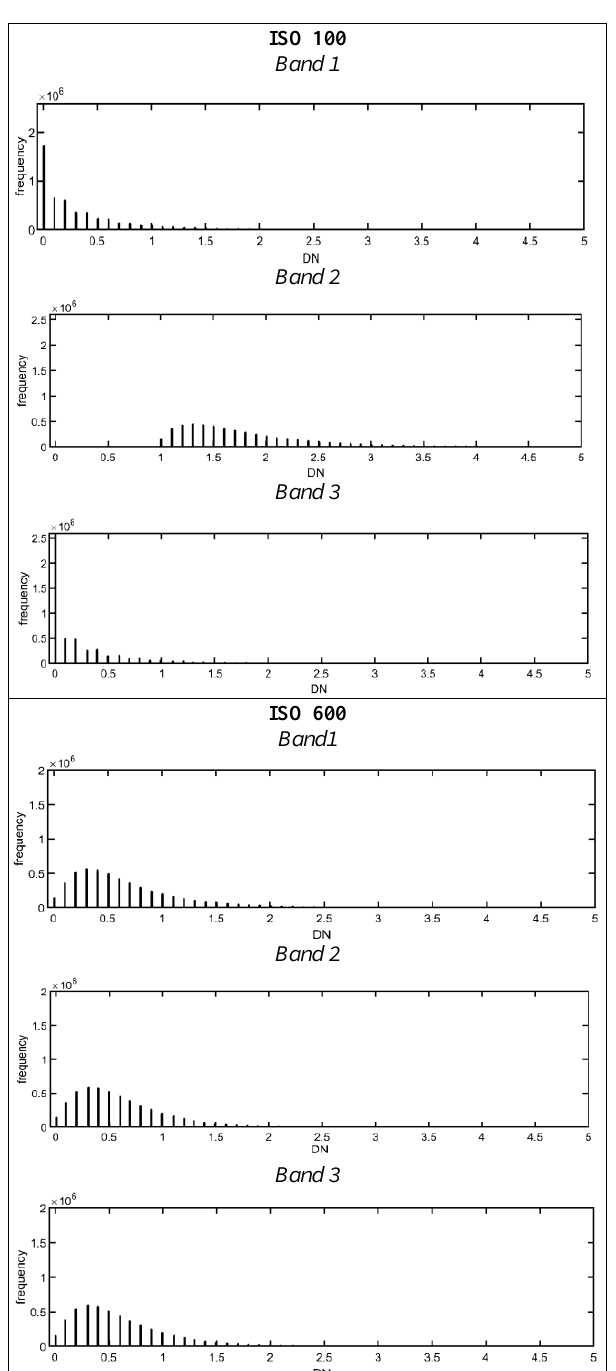
Figure 3. Histograms of distribution of dark frame assessment at 100 ISO (up) and 600 ISO (down) per band Figure 2. Raspberry Pi camera spectral response. Source: